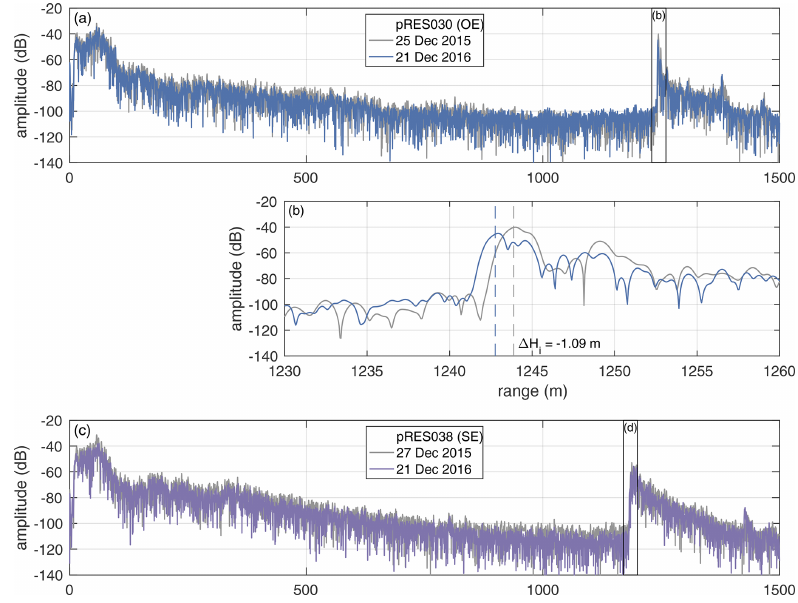
Figure A2. Amplitude profiles of first (gray line) and repeated pRES measurements at locations OE ( a, b ; blue), SE ( c, d ; purple) and L ( e, f ; red), all at the cross-section with a distance of 48km from the grounding line. (b, d, f) Enlarged basal section, visualized by black boxes in panels (a) , (c) and (e) . Vertical dashed lines mark the ice thickness and (cid:49)H i the change in ice thickness between both visits.